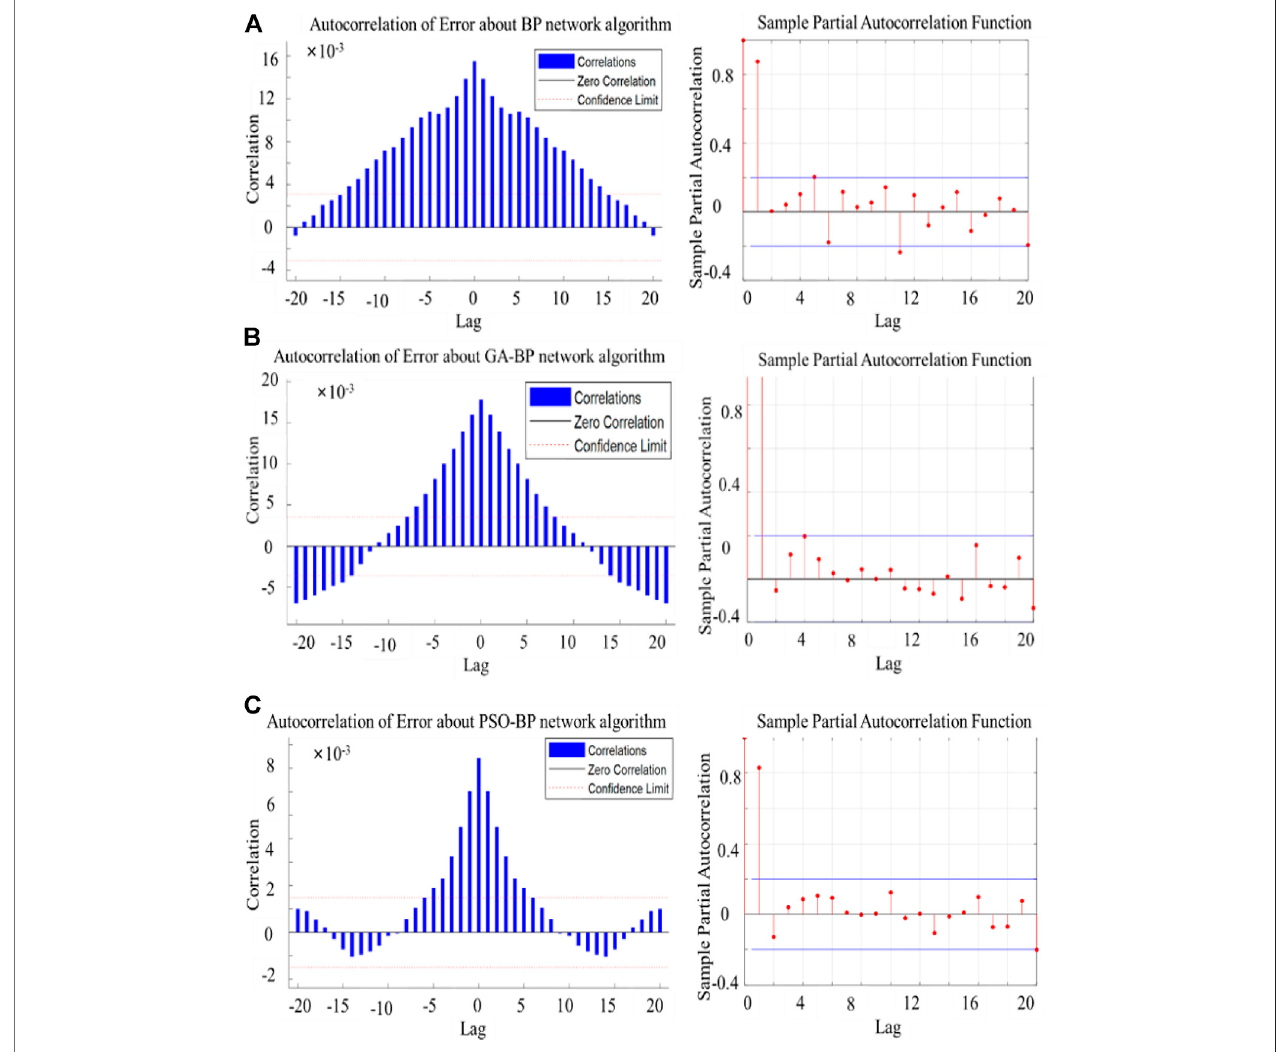
FIGURE 8 | Autocorrelation and partial correlation of prediction errors of different algorithms. (A) Autocorrelation and partial correlation of standard BP neural network. (B) Autocorrelation and partial correlation of GA-BP neural network. (C) Autocorrelation and partial correlation of PSO-BP neural network.